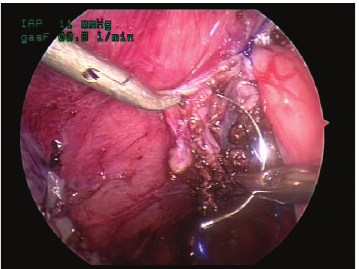
Figure 6: Suturing is back-hand with the instruments medial to the